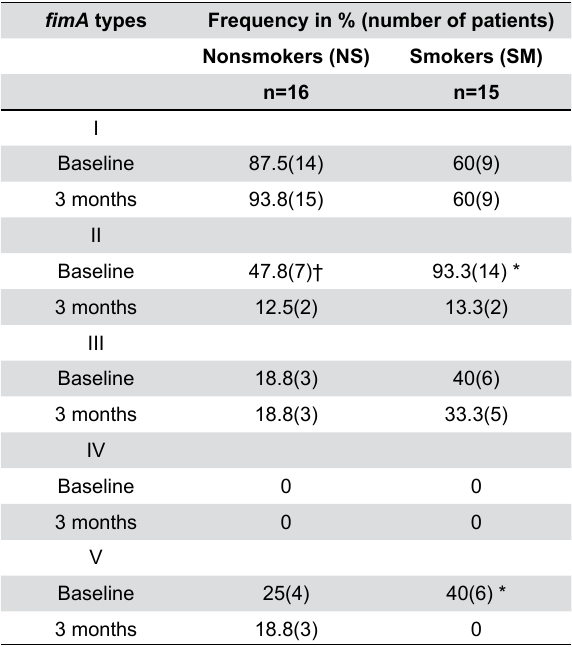
Table 2- Clinical evaluation of smokers versus nonsmokers at baseline and after 3 months of periodontal therapy. Values are expressed in medians (percentile 25-percentile 75)